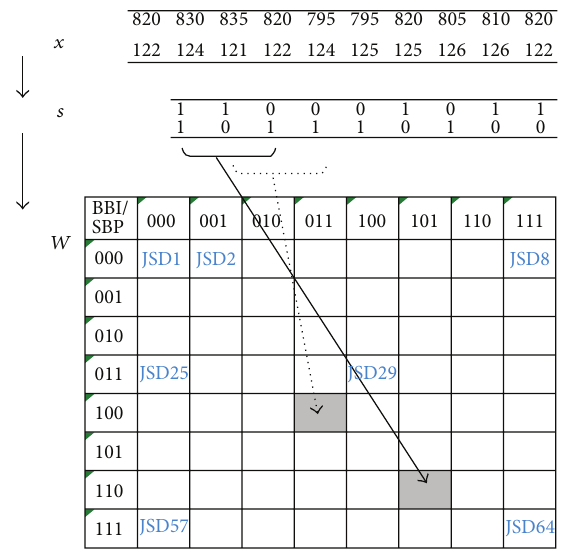
Figure 3: The method of Joint Symbolic Dynamics (JSD) quantifies the short-term bivariate nonlinear behavior (coupling) of blood pressure and heart rate. JSD transforms BBIs (beat-to-beat intervals) and diastolic or systolic blood pressure time series into symbol sequences of different words (3 successive symbols are one word) according to the pattern of change (increase or decrease) [14]. Top: 𝑥 as time series of BBI (in ms) and systolic blood pressure values (in mmHg). Middle: 𝑠 as symbol vector. Bottom: 𝑊 as word type matrix with BBI (columns); SP, systolic blood pressure (rows). With JSD1 ... JSD64 as coupling